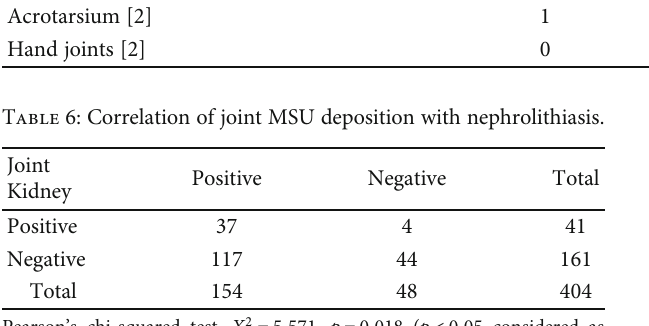
Attacked joints [28].